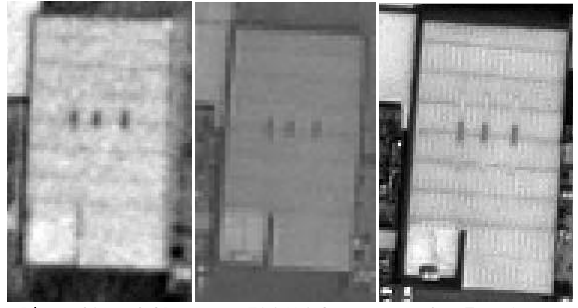
Figure 10. From left: building in aerial photo 63cm GSD, IKONOS and GeoEye-1